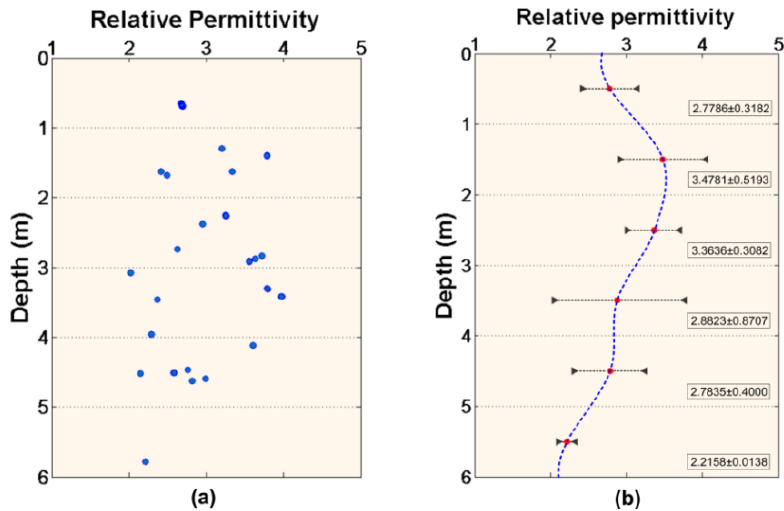
Figure 16. Analysis between permittivity and the depth. ( a ) Scatterplot of permittivity and depth. ( b ) The average estimated dielectric constant of regolith at each meter. The error bars show the standard deviation.